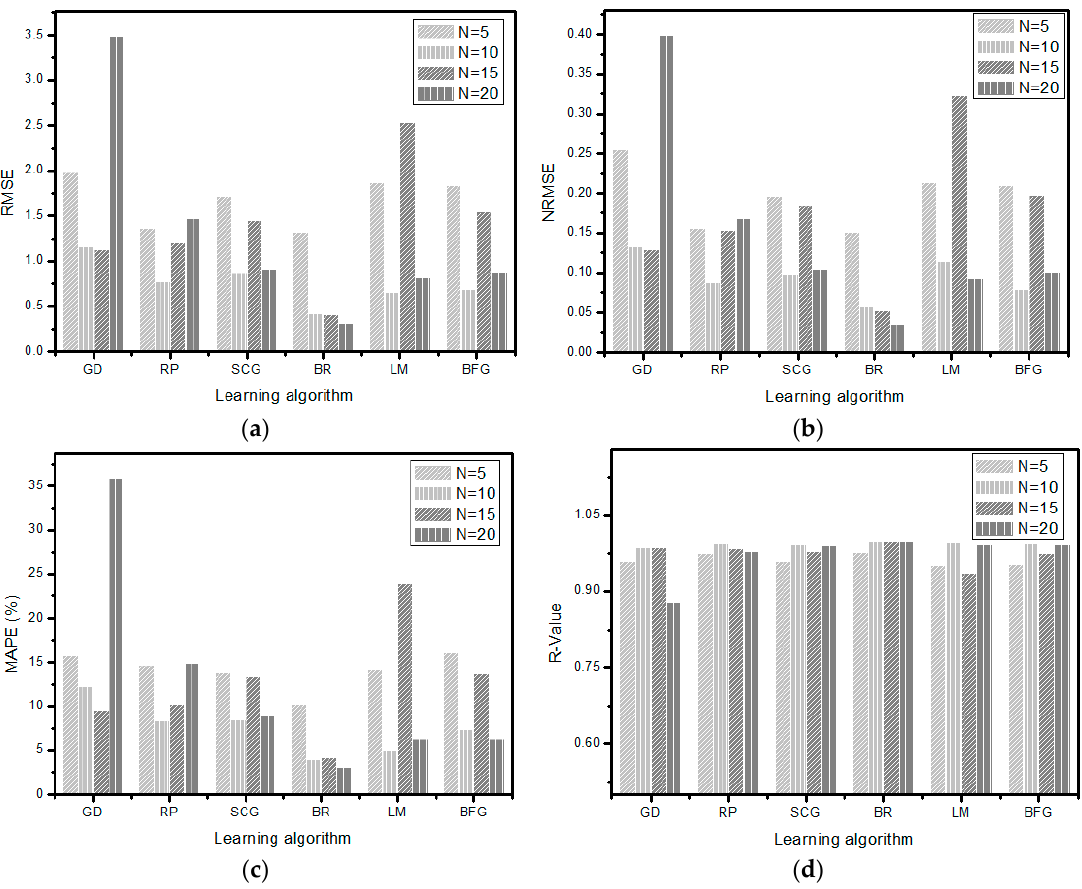
Figure 10. Performance parameters comparison of the different learning algorithms on the basis of changes in the number of neurons in the hidden layer. ( a ) RMSE; ( b ) NRMSE; ( c ) MAPE (%); ( d ) R value.